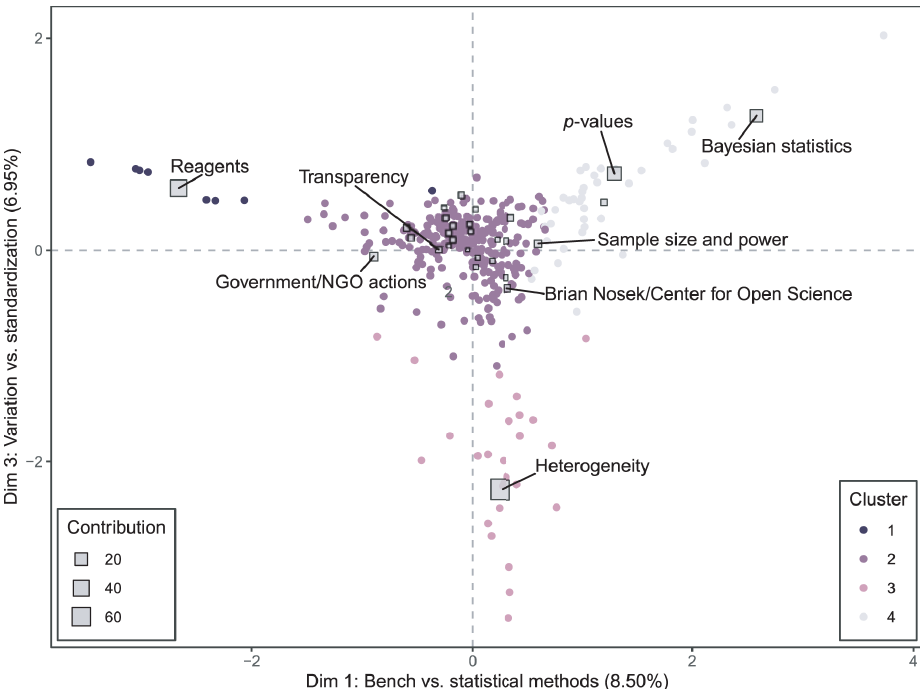
Fig 4. Correspondence analysis biplot depicting dimensions 1 and 3 of the analysis. Articles that are close together have similar narrative profiles. The closer an article appears to the center of the plot, the more closely it resembles the mean profile for all articles. The further away a theme is from the origin, the more variation there is in how authors discuss that theme. The color of an article’s plotted point (a circle) indicates their label in a hierarchical clustering, based on Euclidean distance in the latent dimensions. The size of a theme’s plotted point (a square) represents the contribution of that theme to constructing the dimensions. The eight most contributing themes are labeled.